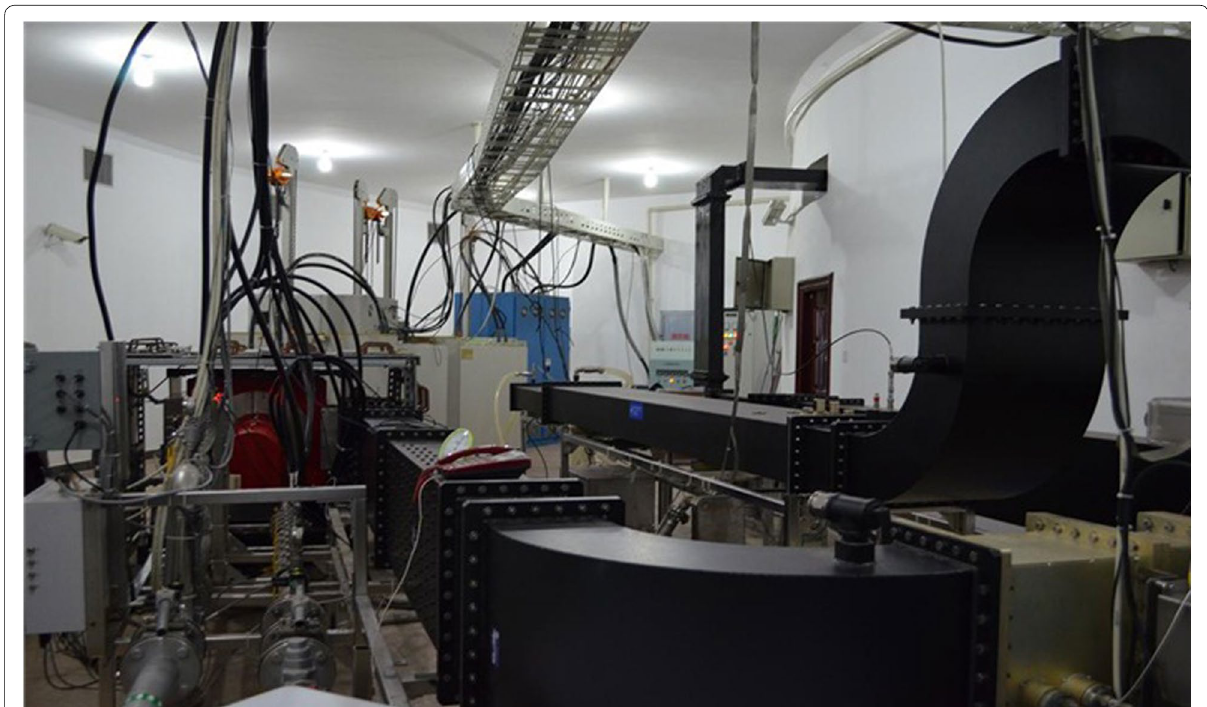
Fig. 4 Photograph showing the overall view of the transmitter